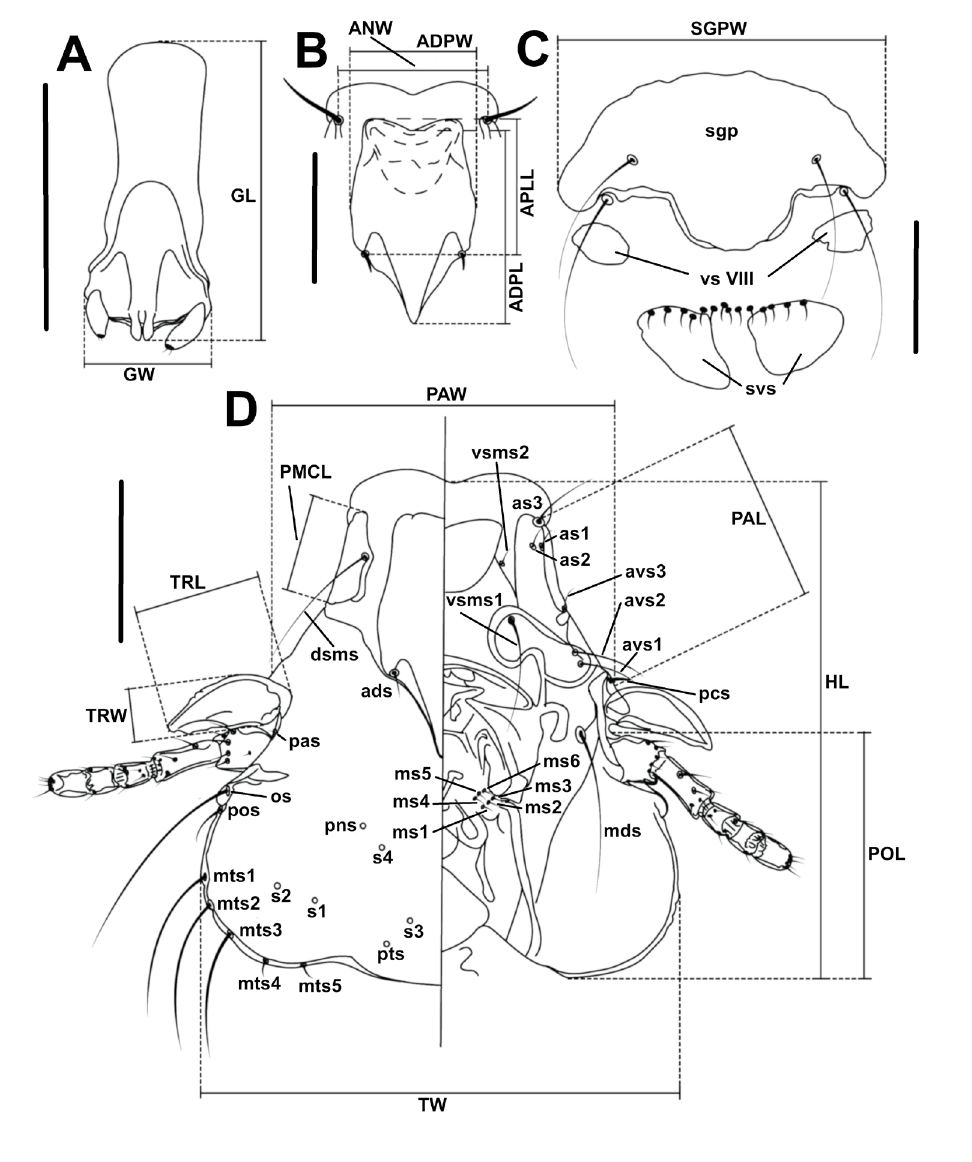
Fig. 2. Philopterus acrocephalus Carriker, 1949 ex Acrocephalus melanopogon (SK25 in MMBC): points of measurements and nomenclature of sclerites and setae. A . Male genitalia, ventral view. B . Male dorsal preantennal plate (ADP), dorsal view. C . Female subgenital plate and ventral terminalia, ventral view. D . Male head, dorsal and ventral views. Abbreviations: sclerites: sgp – subgenital plate; svs – subvulvar sclerite; vs VIII – vestigial sternite VIII; setae: ads – anterior dorsal seta; as – anterior seta; avs – anterior ventral seta; dsms – dorsal submarginal seta; mds – mandibular seta; ms – mental seta; mts – marginal temporal seta; os – ocular seta; pas – preantennal seta; pcs – preconal seta; pos – postocular seta; pns – postnodal seta; pts – postemporal seta; s – sensillus; vsms – ventral submarginal seta. Measurements: ADPL – anterior dorsal plate length; APLL – anterior dorsal plate lateral length; ADPW – anterior dorsal plate width; ANW – anterior notch width; GL – male genitalia length; GW – male genitalia width; HL – head length; PAL – preantennal length; PAW – preantennal width; PMCL – premarginal carina length; POL – postantennal length; TRL – trabecula length; TRW – trabecula width; TW – temporal width; SGPW – subgenital plate width. Scale bars: 0.1